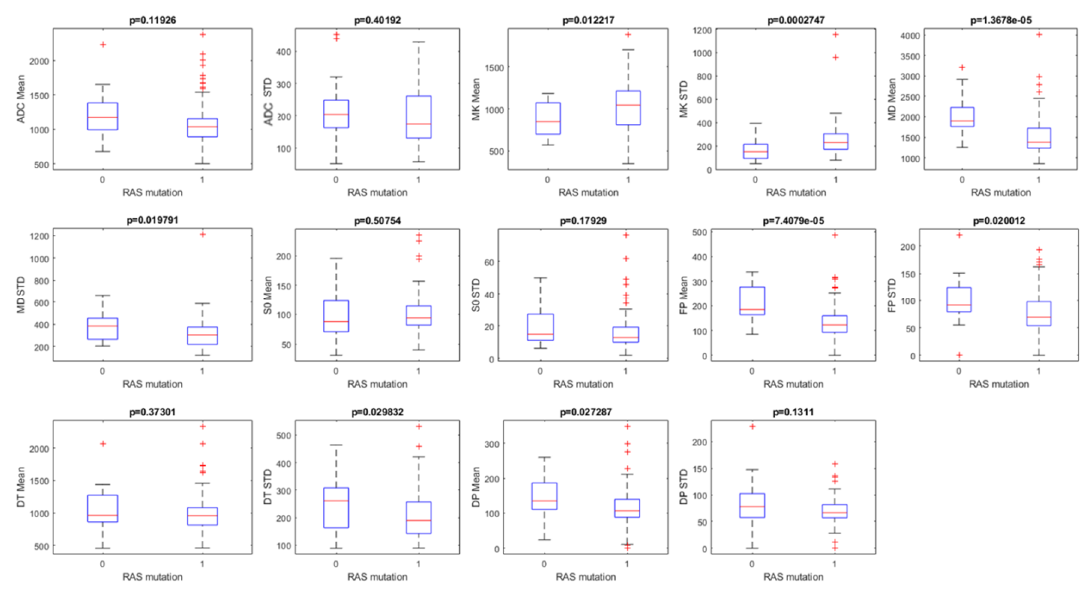
Figure 1. Boxplot of Apparent Diffusion Coefficient (ADC)-, Intravoxel Incoherent Motion method (IVIM)- and Diffusion Kurtosis Imaging (DKI)-derived parameters to differentiate presence/absence of RAS mutation.